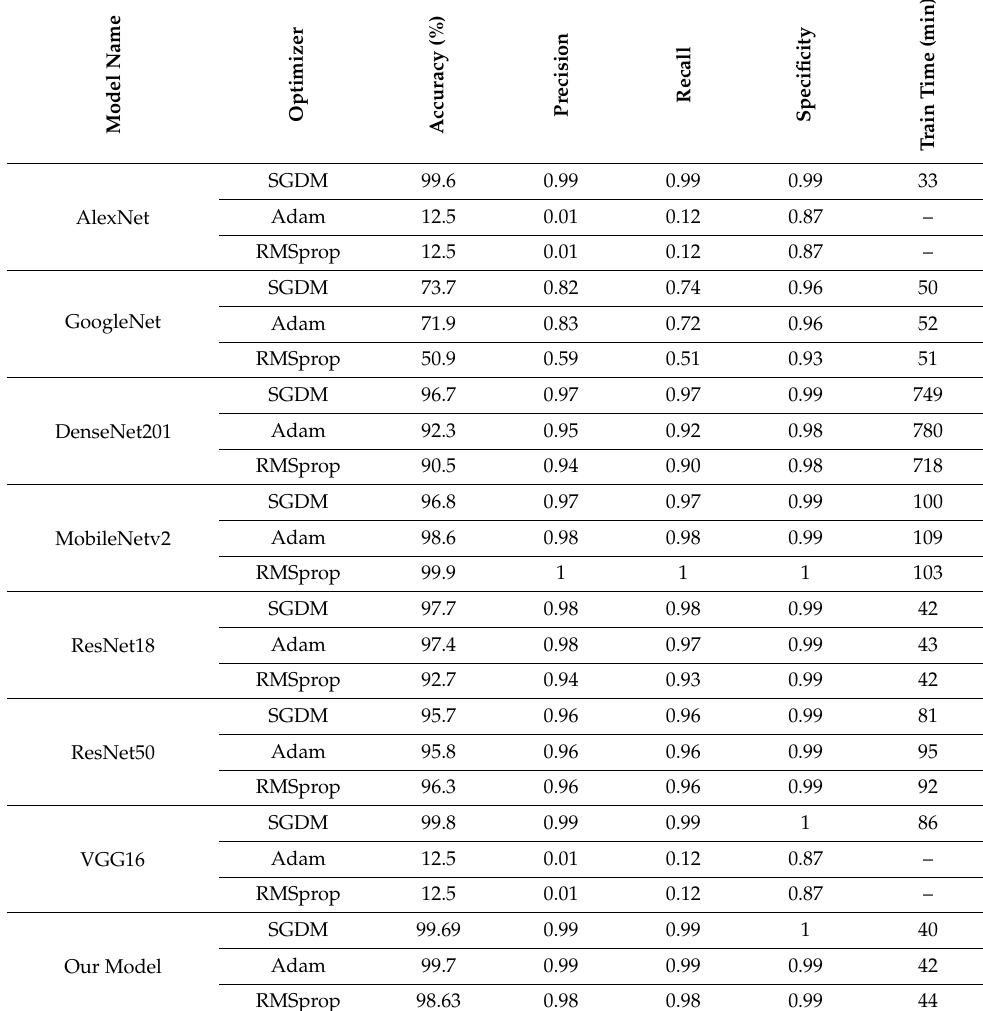
Table 7. Performance Metrics for COLOR QR Code.